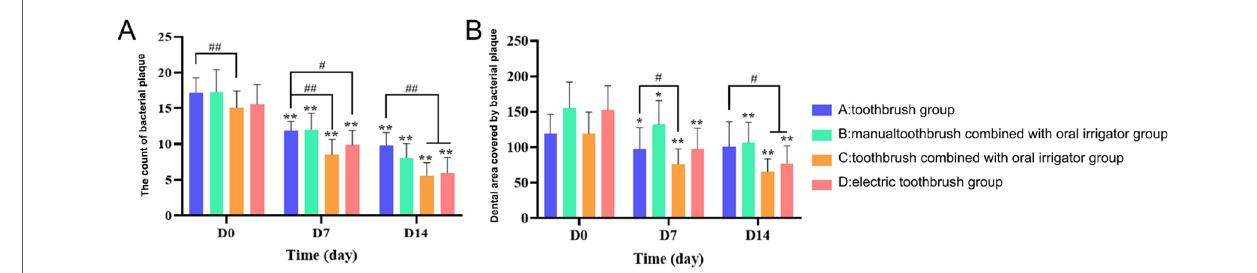
FIGURE 3 Labial/buccalplaquecount( A )andplaqueareabarchartofanteriorteethandpremolars( B ).Thetestdataofthesampleaccordwiththenormaldistribution.Intra- group differences were indicated by * P <0.05 and ** P <0.01;The differences between groups were indicated by # P <0.05 and ## P